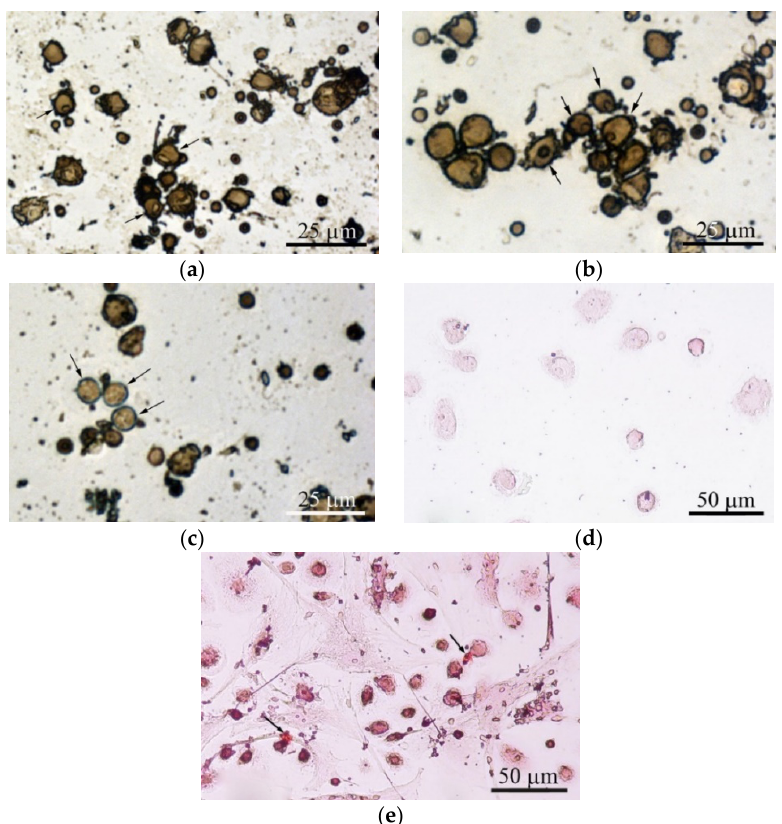
Figure 6. hBMNC monocultures after 3 days ( a )–( c ) and 21 days ( d ), ( e ) in a standard nutrient medium. ( a ) 2D culture of hBMNCs on plastic surface; ( b ), ( c ) 3D culture of hBMNCs around CaP ‐ coated specimen. Alkaline phosphatase (ALP) staining with fast blue PP salt. Some cells with nucleoli ( a ), ( b ) and single adherent ALP ‐ positive cells with blue stained cytoplasm ( c ) are marked by black arrows; ( d ) adherent round cells; ( e ) adherent round and fibroblast ‐ like cells. Small sites of mineralization stained with alizarin red are shown by black arrows. Scale bars 25 and 50 μ m. The macrophage ‐ like shape of hBMNCs was accompanied by the increased expression of stromal antigens (CD90, CD105, and especially CD73) but not CD14 (Table S4). hBMNCs secreted a notable concentration of angiogenic molecules (PDGF ‐ BB) after 14 days of cultivation (Table S2). Round hBMNCs in 21 ‐ day 2D cultures were negative for alizarin red staining (Figure 6d). However, adherent cells (0–1.6% per well) had a fibroblast ‐ like shape. Surprisingly, single small sites of alizarin red staining (ECM mineralization) were observed at places of contact between round and fibroblastoid cells (Table 2; Figure 6e). Therefore, the data suggest that CaP ‐ coated samples caused the accumulating biomass of CD73 + endothelial cells (angioblasts) and/or MSCs/osteoblasts in adherent hBMNC culture (Figure 6b,c).